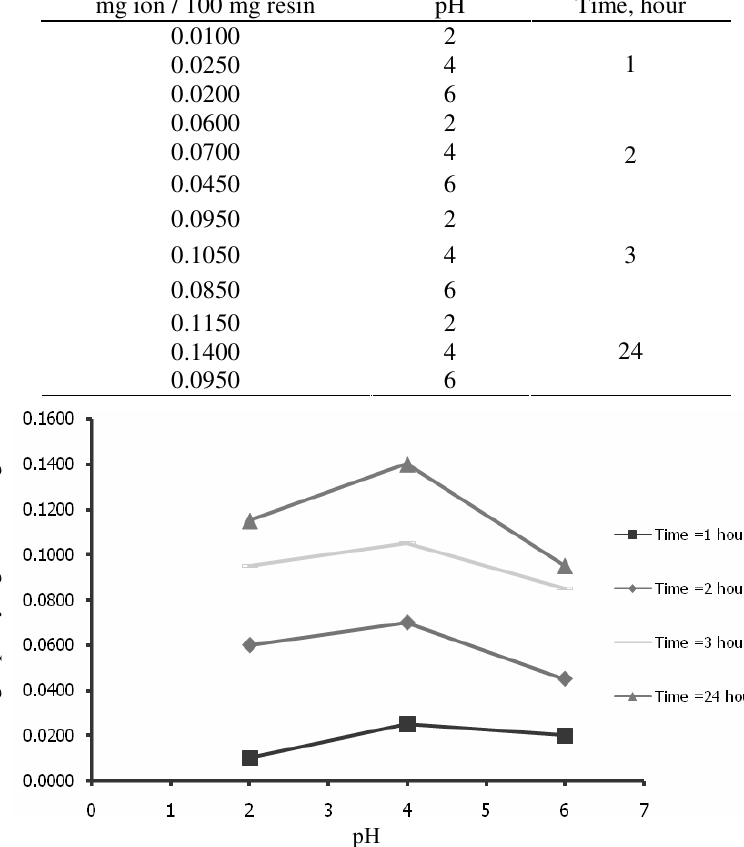
Figure 5. The effect of the loading capacity for Ni(II)